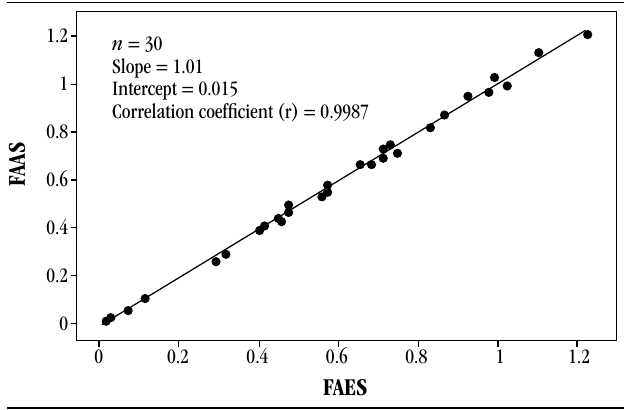
figurE 3 – Correlation between the results obtained by the techniques FAAS and FAES FAAS: flame atomic absorption spectrometry; FAES: flame atomic emission